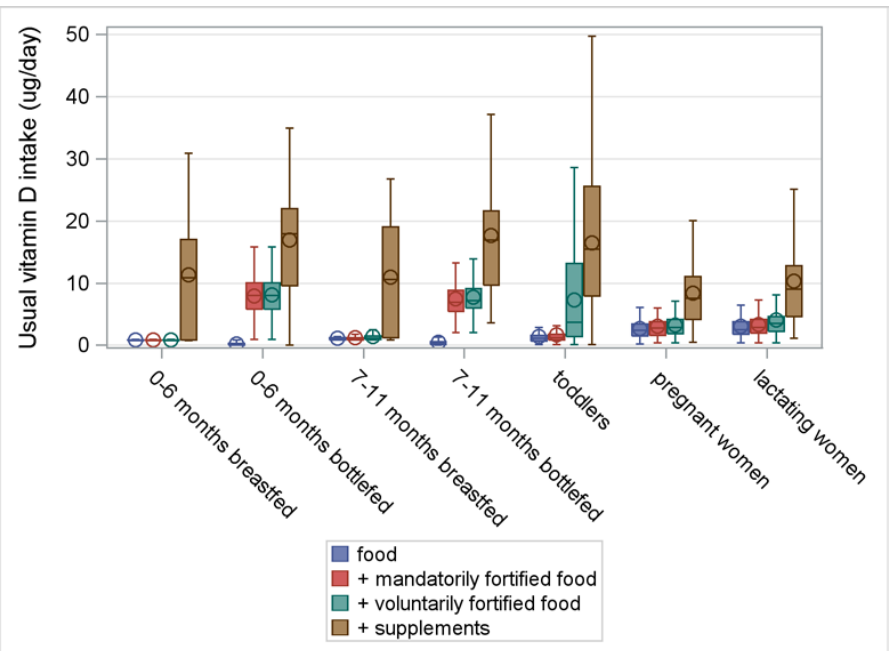
Figure 2. Usual intake of vitamin D (μg/day) from food, fortified food, and supplements in infants, toddlers, pregnant women, and lactating women from a Belgian study on the intake of vitamins A, D, E, and K (VITADEK-study) 2015.